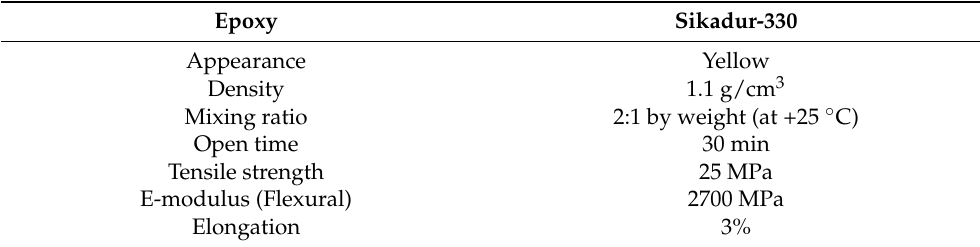
Table 3. Mechanical properties of epoxy adhesive (provided by Sika, Baghdad, Iraq).